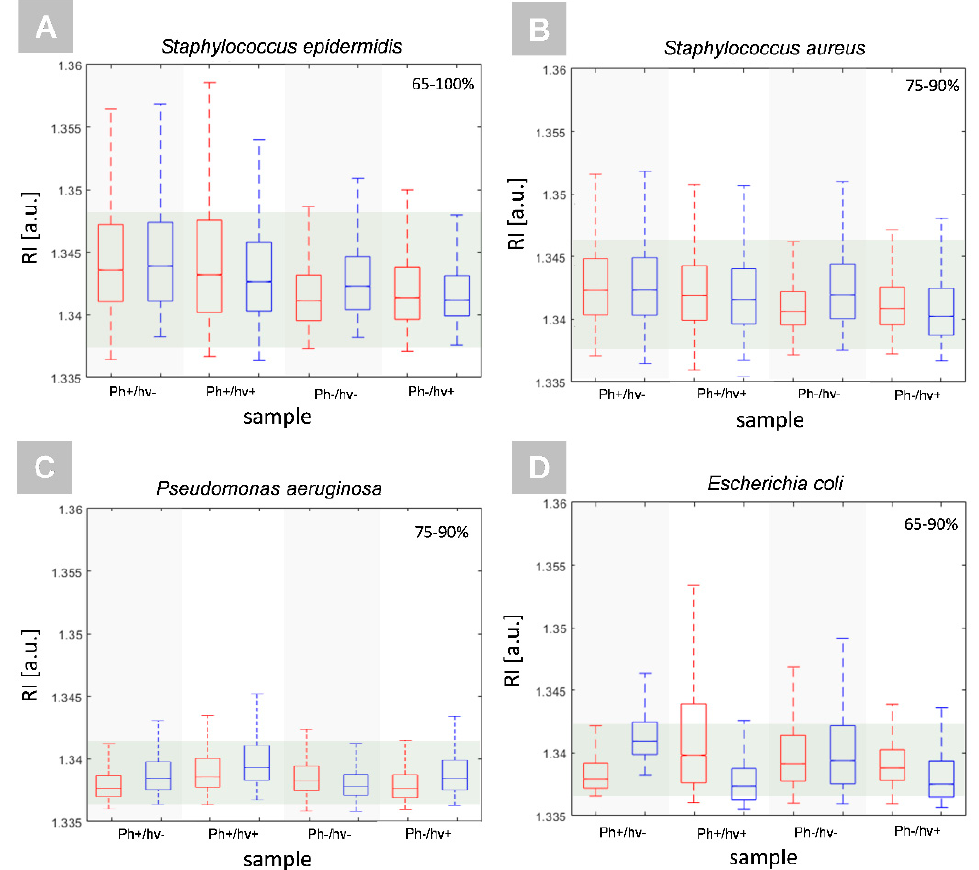
Figure 8. Representative box plots of RI values of single cells of Gram positive: ( A ) S. epidermidis and ( B ) S. aureus , and Gram negative bacteria species: ( C ) P. aeruginosa and ( D ) E. coli that were cultivated on different surfaces (Ph+/h ν -: PS-doped silica coating not illuminated, Ph+/h ν +: PS-doped silica coating illuminated, Ph-/h ν - silica coating not illuminated, and Ph-/h ν +: silica coating illuminated). The red boxes represent the results before PS photoexcitation, and the blue boxes 24 h after PS photoexcitation (aPDT treatment). The percentage values determine the percentage of observations with similar RI values as indicated by the green region.